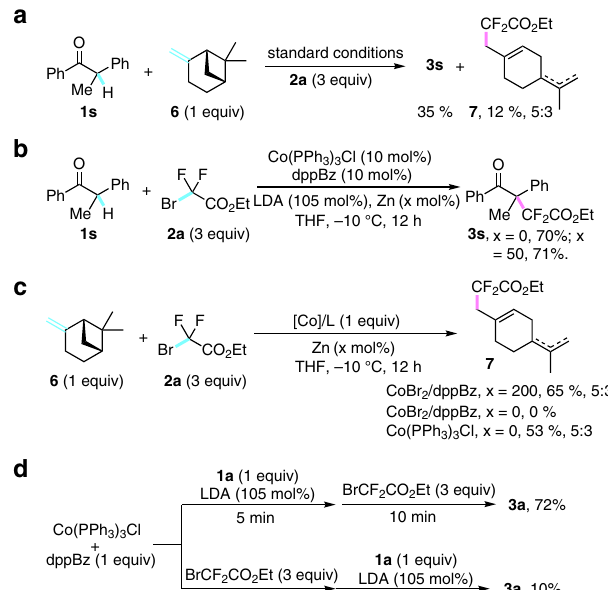
Fig. 4 Mechanistic studies. a Radical trapping experiment with β -piene. b Control experiments using Cobalt(I) complex. c Studies on generation of